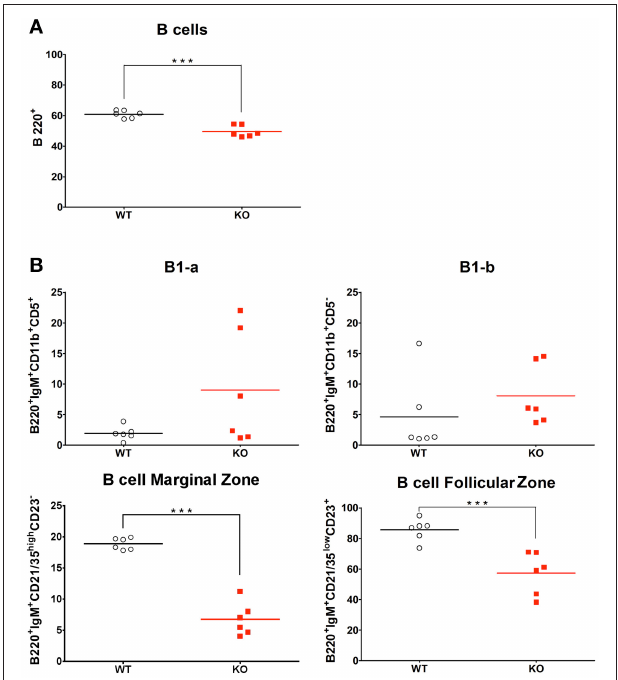
FIGURE 6 | Splenic percentage of marginal and follicular zone B cells in WT and KO mice. Percentage of total B cells (A) and their subtypes (B) : B1-a, B1-b, marginal zone B cells and follicular zone B cells in the spleen of WT ( ◦ ) and KO ( ) mice in basal conditions. All results are presented as individual and mean response. N = 6 mice per group. *** p < 0.0001 (unpaired Student t -test).